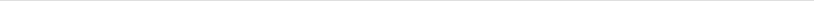
(See figure on next page.) Fig. 3 Mindin deficiency limited renal IR induced inflammatory cell infiltration and proinflammatory mediators production. A Representative photomicrographs showing IHC staining of LY6G in WT and mindin KO mice induced by IR or not (magnification 400 ). B Quantitative analysis × of LY6G in the indicated groups. *P < 0.05 versus WT Sham or KO Sham. # P < 0.05 versus WT IR. C Representative photomicrographs showing the IHC staining of CD68 in WT and mindin KO mice induced by IR or not (magnification 400 ). D Quantitative analysis of CD68 in the indicated × groups.*P < 0.05 versus WT Sham or KO Sham. # P < 0.05 versus WT IR. E Representative photomicrographs showing IHC staining of TNF-α in WT and mindin KO mice induced by IR or not (magnification 400 ). F Quantitative analysis of TNF-α in the indicated groups.*P < 0.05 versus WT Sham or KO × Sham. # P < 0.05 versus WT IR. G Representative photomicrographs showing IHC staining of MCP-1 in WT and mindin KO mice induced by IR or